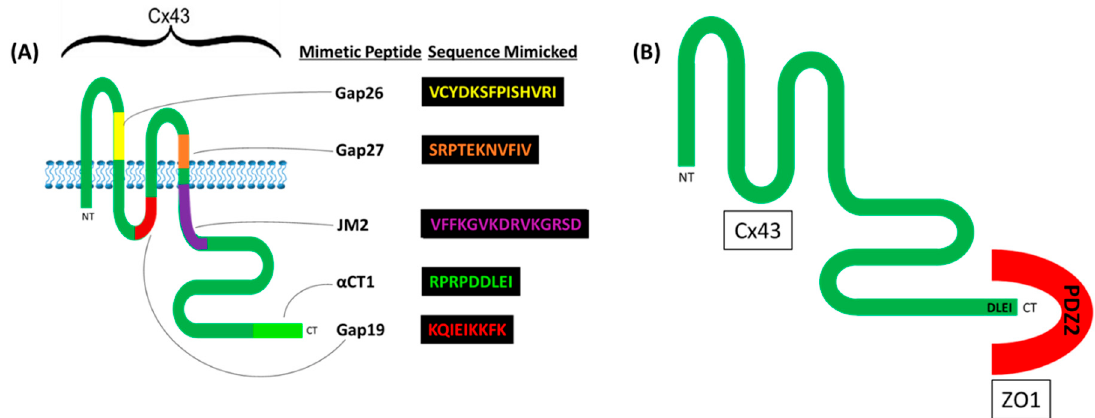
Figure 1. Cx43 structure and the amino acid sequences contained within Cx43 mimetic peptides. ( A ) Cx43 contains four conserved α -helical transmembrane domains, two extracellular loops, a cytoplasmic loop, and cytoplasmic amino (N)- and carboxyl (C)-terminal domains. Cx43 mimetic peptides mimic Cx43 function by containing sequences identical to those found within these domains. ( B ) Cx43 (cid:48) s PDZ2-binding ligand (DLEI), contained at the terminal-most portion of its CT, inserts into the PDZ2 domain of